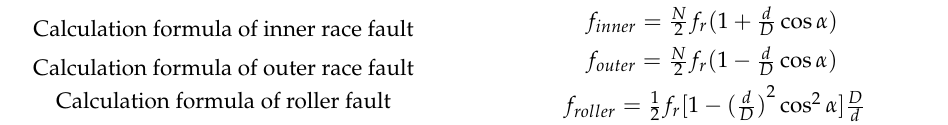
Table 5. The characteristic frequency calculation table for different bearing faults.